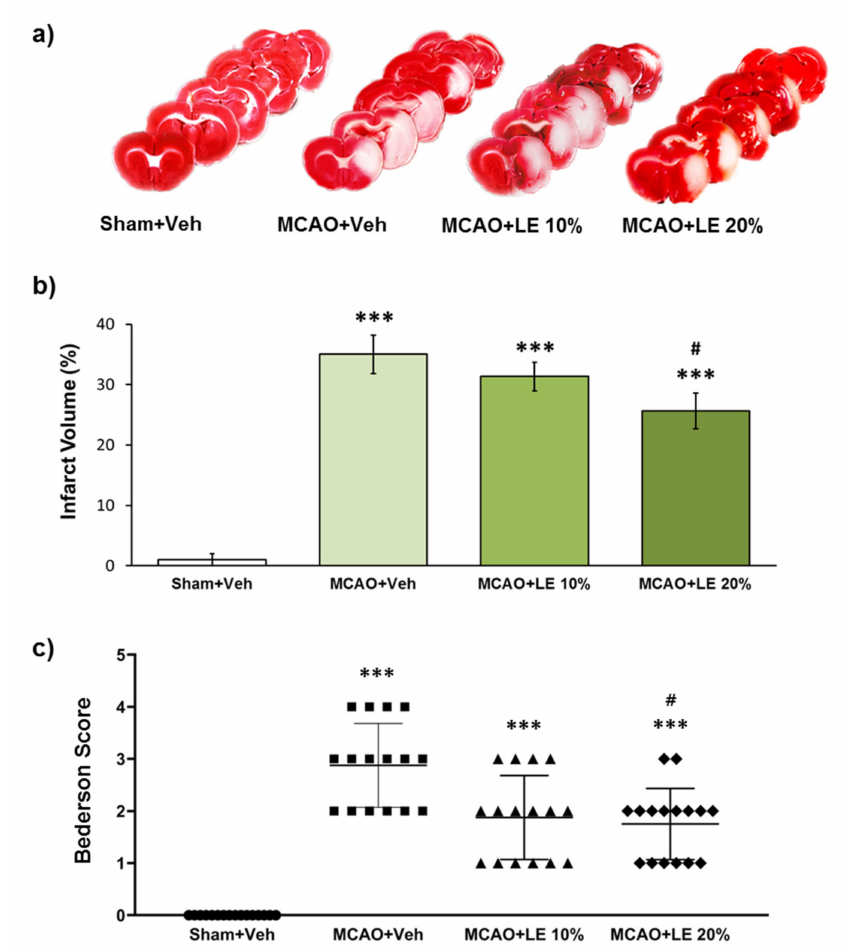
Figure 1. Neuroprotective e ff ects of lipid emulsion (LE) or vehicle (Veh) after the middle cerebral artery occlusion (MCAO) and reperfusion injury. ( a ) Triphenyltetrazolium chloride (TTC)-stained brain slices for infarction measurement. Decrease in infarction volumes were observed in MCAO + LE 10% and MCAO + LE 20% groups. Sham group did not show ischemic reperfusion injury; ( b ) Measurement of infarction volume from TTC staining. The MCAO + Veh group increased significantly in infarction volume compared to Sham + Veh group. Both MCAO + LE 10% and MCAO + LE 20% decreased in infarction volume but only the MCAO + LE 20% group had significant di ff erence compared to the MCAO + Veh group; ( c ) Bederson scores of the experimental groups. The MCAO + Veh group increased in Bederson score significantly compared to Sham + Veh group. Both MCAO + LE 10% and MCAO + LE 20% groups decreased in Bederson scores compared to MCAO + Veh group; however, only the MCAO + LE 20% group decreased significantly. Data are presented as mean ± standard error of the mean (SEM); n = 16 for each group; *** p < 0.001 vs. Sham + Veh, # p < 0.05 vs. MCAO + Veh. Statistical analysis for the measurement of infarction volume was performed using one-way analysis of variance (ANOVA) followed by Tukey’s multiple comparison test. Statistical analysis for Bederson scores was performed using Kruskal-Wallis non-parametric test followed by Dunn’s post hoc